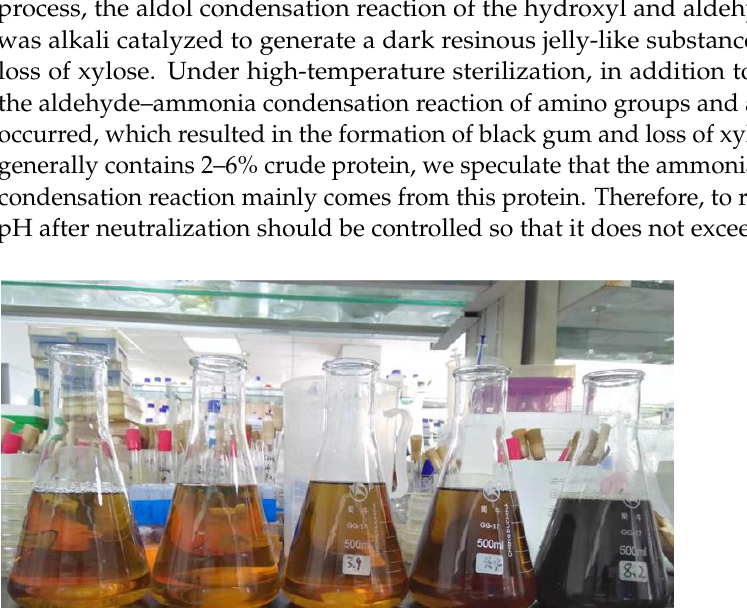
Table 1. Effect of different pH values on xylose loss during concentration and sterilization.